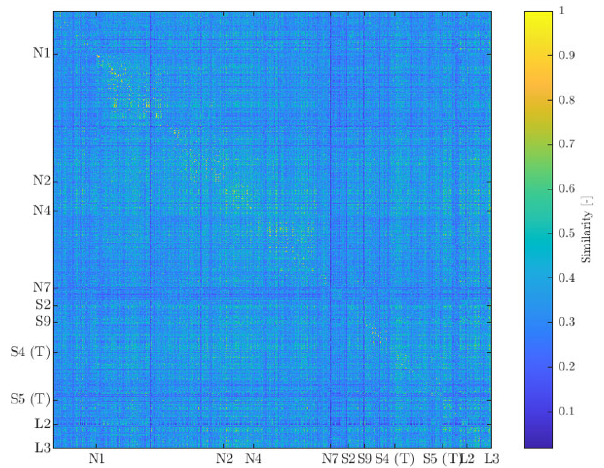
Figure 13. Similarity matrix containing all 15,081 waveforms measured during loading and failure of the ten specimens. Indices relate to the last wave form from the specimen.